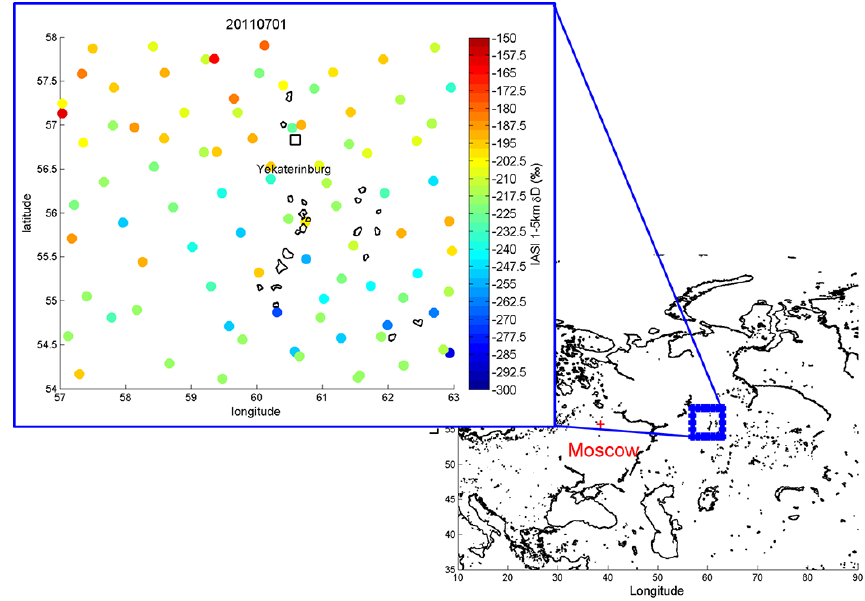
Figure 1. IASI cloud-free observation of 1–5km δ D (in ‰) over the Yekaterinburg area (YEK) on 1 July 2011; only one pixel out of four is processed and shown. Each circle represents the observation at the location of the centre of each pixel. The city is marked with the square.